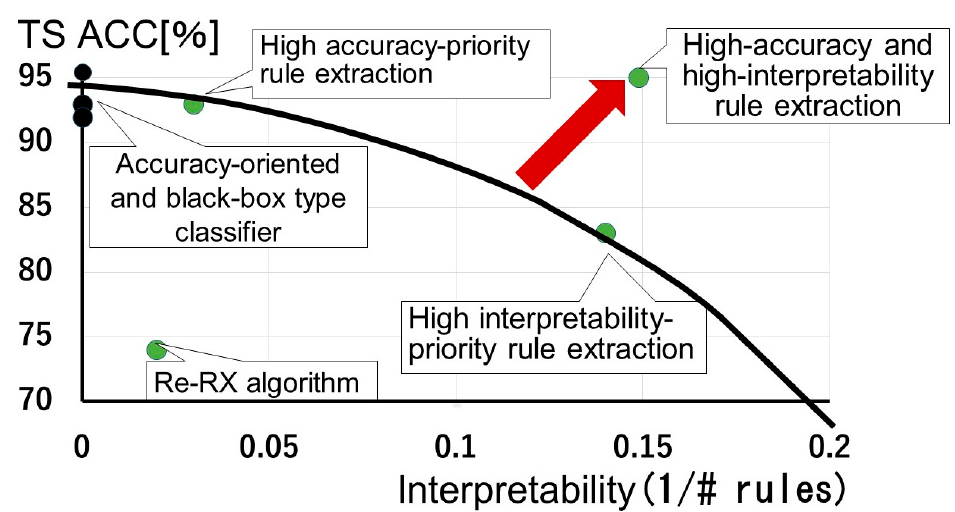
Figure 1. Trade-off curve for accuracy-oriented and “black box” classifiers, high accuracy-priority rule extraction, high interpretability–priority rule extraction, and high-accuracy and interpretability rule extraction.